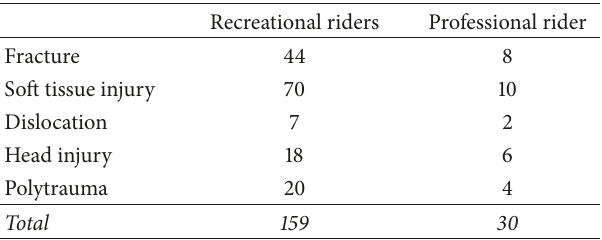
Table 3: Injury distribution between recreational and professional riders.